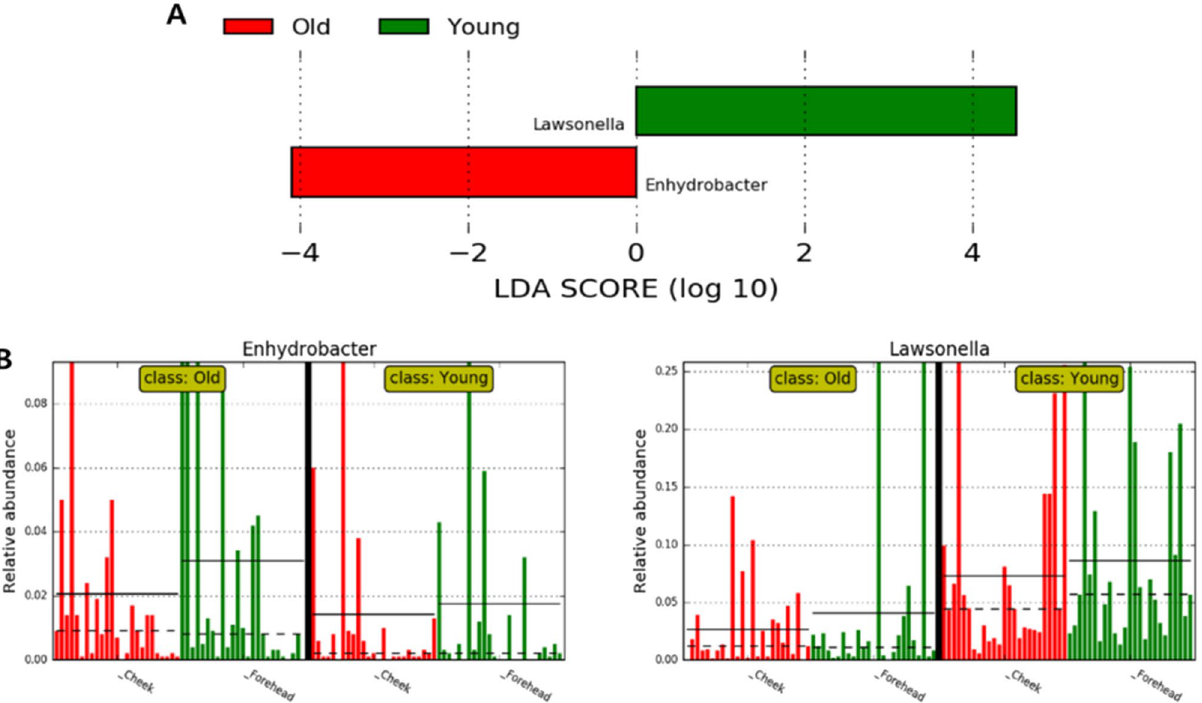
Figure 8. Taxonomic differences from LEfSe analysis. ( A ) Linear discriminative analysis (LDA) scores are calculated at the genus level with subcategories of skin site between younger group (green) and older group (red); ( B ) Relative abundance (%) of dominant genera in skin site (cheek and forehead) classified by